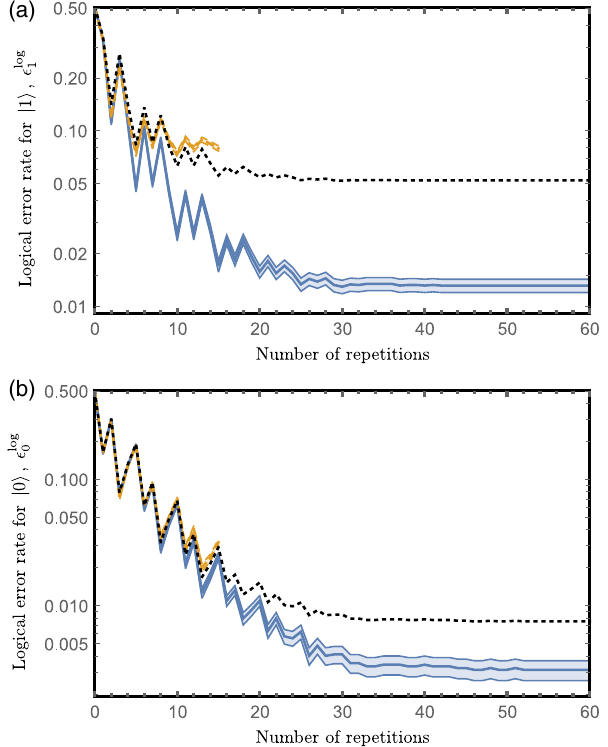
FIG. 5. Simulated logical readout error rate (solid blue line) as a function of the number of repetitions for (a) state j 1 i and (b) state j 0 i . In both cases, the experimentally measured logical readout error rate is shown for comparison (dashed yellow line). The bands give the statistical error associated with the binomial statistics of the sampled errors as explained in Appendix D. Moreover, the dotted black curves give the simulated curves corrected to fit the experimental curves accounting for finite preparation errors using Eq. (E1). The best fit values for the preparation errors are η 1 ¼ 4% for state j 1 i and η 0 ¼ 0 . 44% for state j 0 i , resulting in an average preparation error of η ¼ 2 . 2%